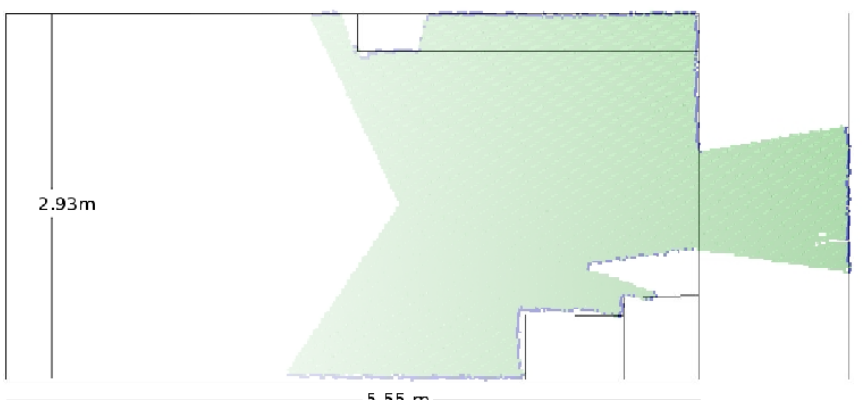
Figure 8. The laser range readings are compared with the true